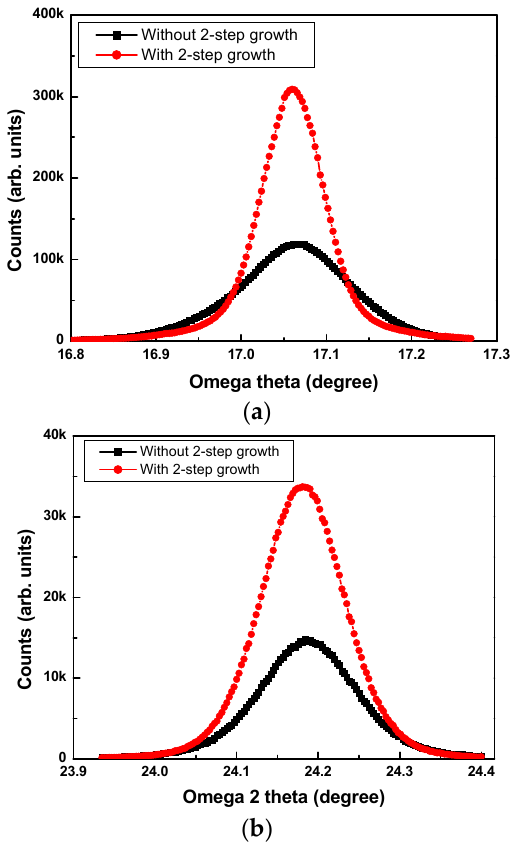
Figure 5. ( a ) Symmetric (002) and ( b ) asymmetric (102) rocking curves GaN grown on Si substrate with and without the two-step growth method.